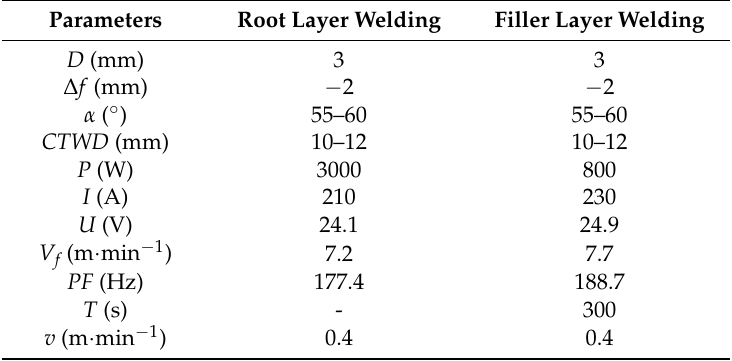
Table 2. Welding parameters, where P is laser power, I is arc current, U is arc voltage, V f is wire feed rate, PF is pulse frequency of I , T is inter pass time, v is welding speed.